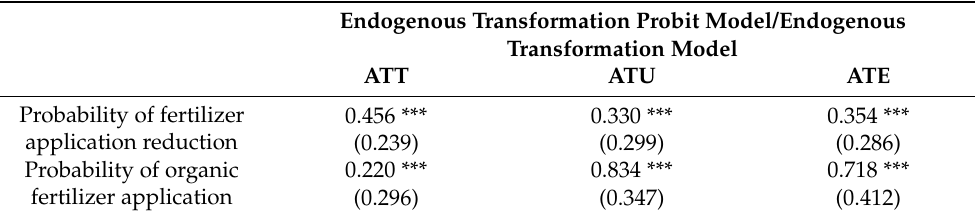
Table 4. Treatment effects of joining cooperatives on reduced fertilizer application by small- holder